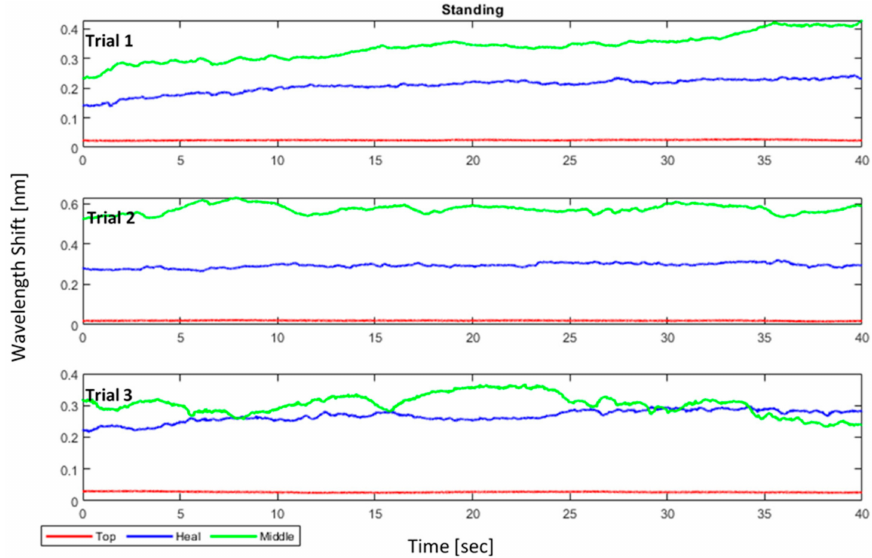
Figure 23. Standing posture wavelength-shifts for 3 trials of a single participant (before normalization).